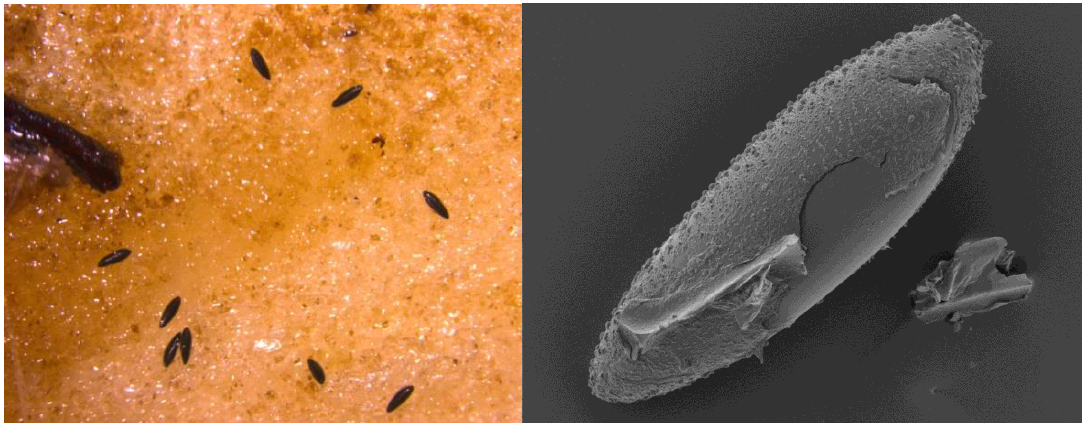
Figure 2. Detection of Aedes albopictus eggs in 2016 in Kent: On substrate and under Scanning Electron Microscope (SEM).